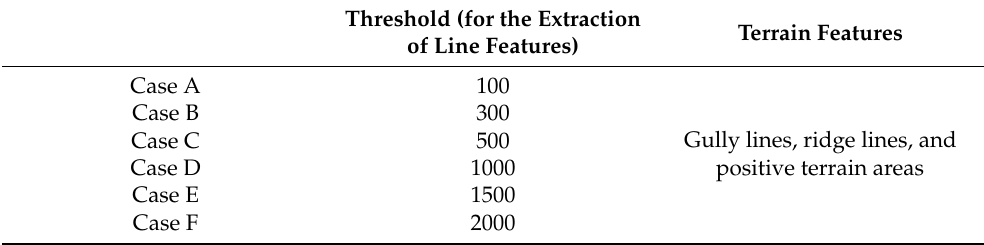
Table 2. Combinations of features with different extraction thresholds.